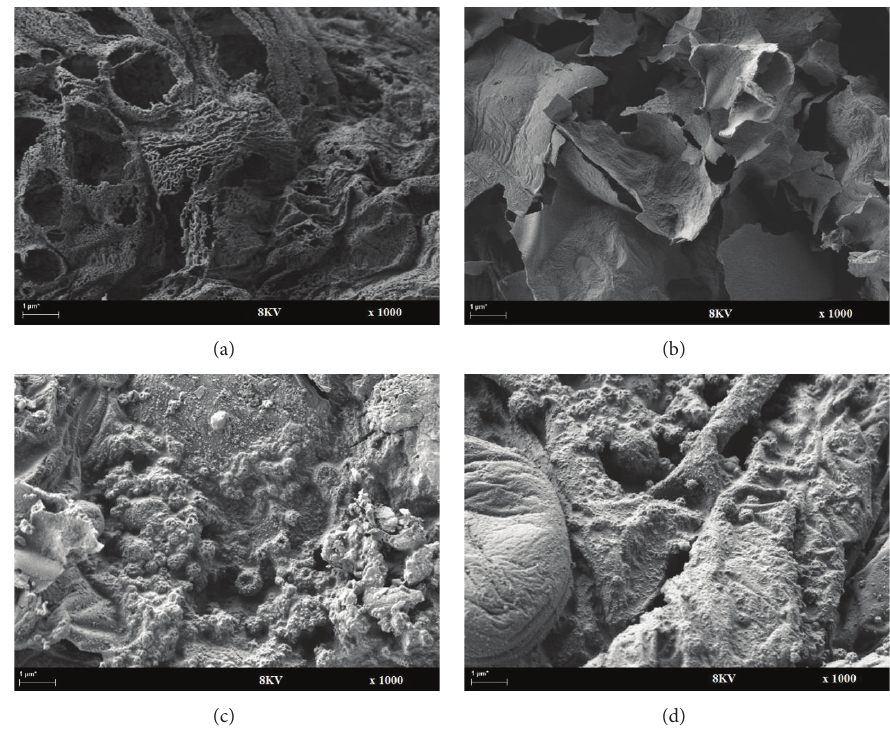
Figure 3: Surface micrographs of the foam structure of samples A, B, C, and D.